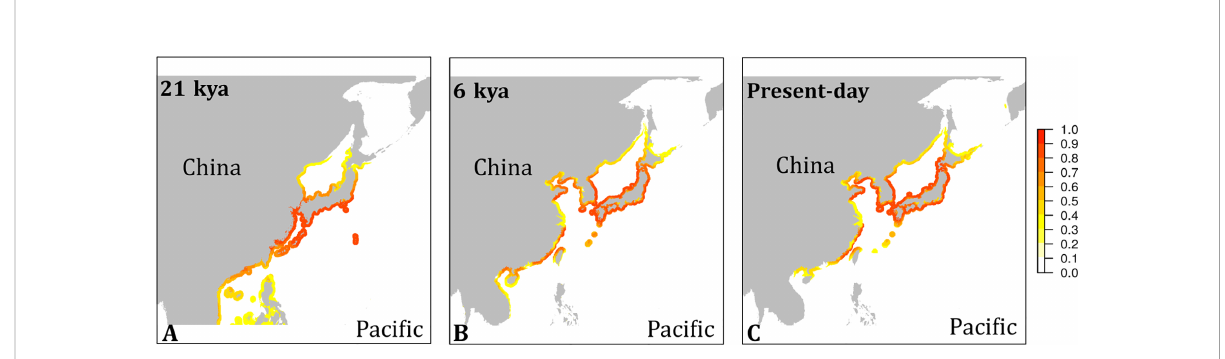
FIGURE 4 Niche model projections of G. vermiculophylla in the northwest Paci fi c. Habitat suitability in cloglog representation at the last glacial maximum (LGM, 21 kya) (A) , the Mid-Holocene (6 kya) (B) , and present time (C)